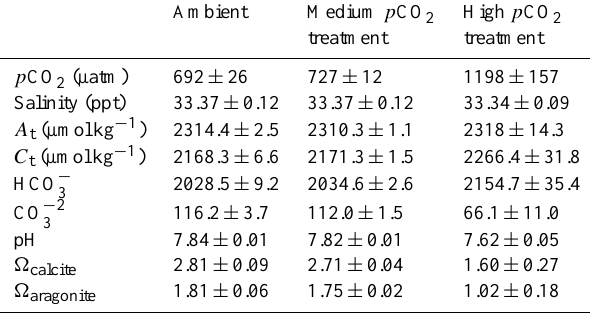
Table 1. Seawater parameters during the OA experiment. A t : to- tal alkalinity; C t : total dissolved inorganic carbon. Analysis of nutrition gave estimates of nitrate (12.3µmolkg − 1 ),